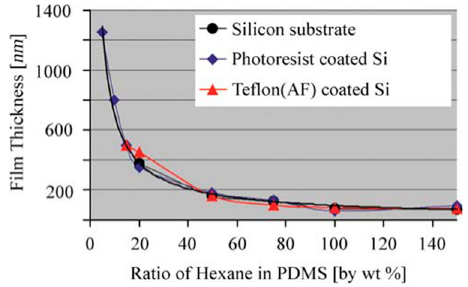
Figure 16. PDMS film thickness on three di ff erent substrates with di ff erent dilution ratios in hexane, adapted from [131] .